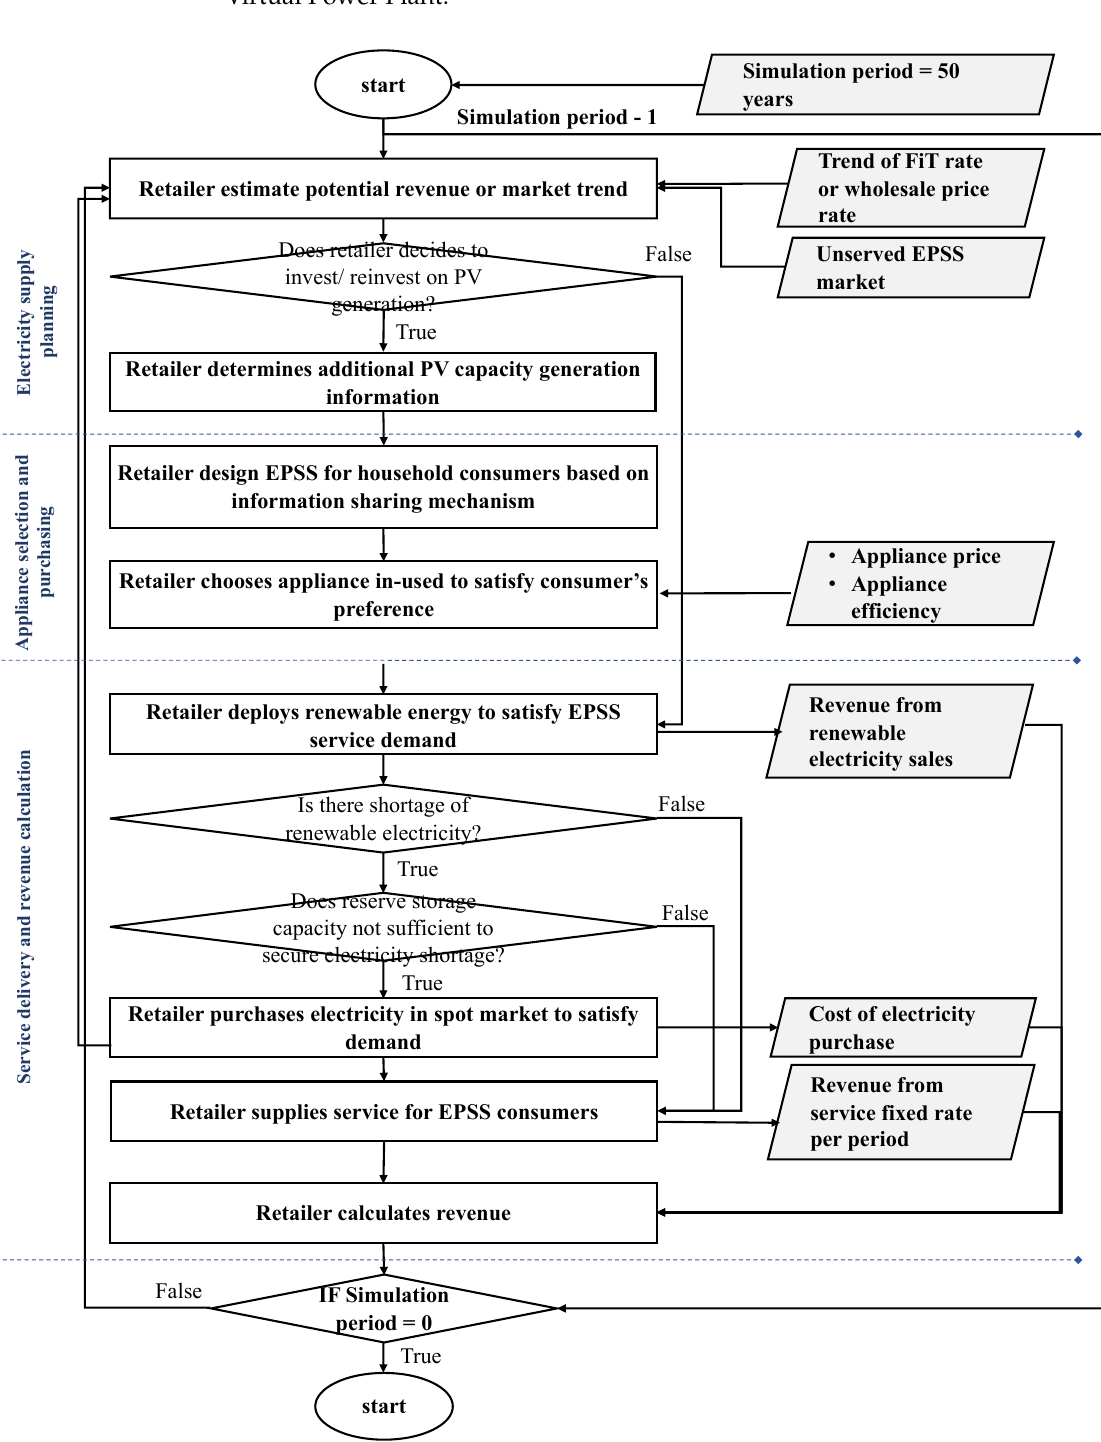
Figure A3. EPSS retailer behavior and decision flow.